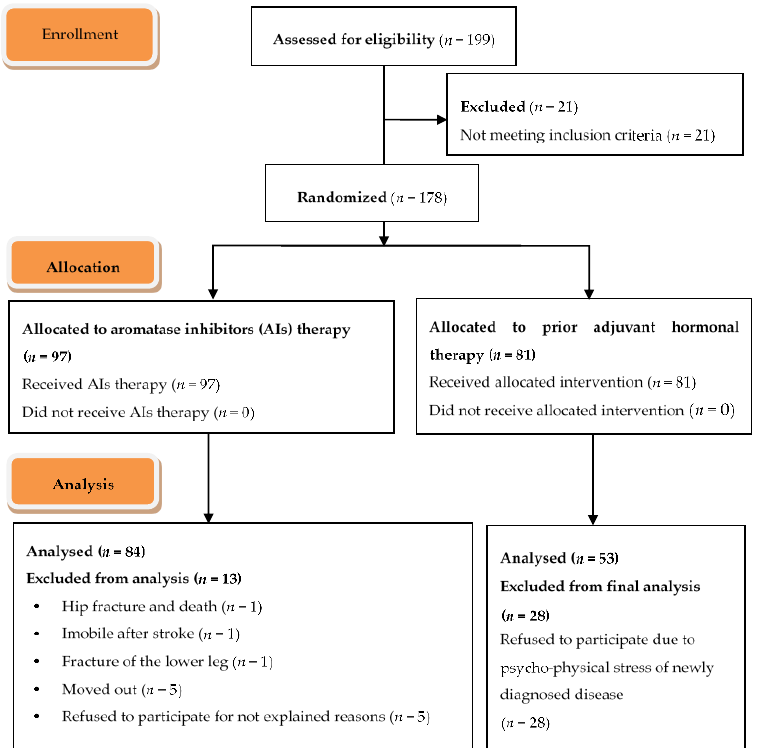
Figure 1. A schematic presentation of flow of study participants from screening to the study endpoint.